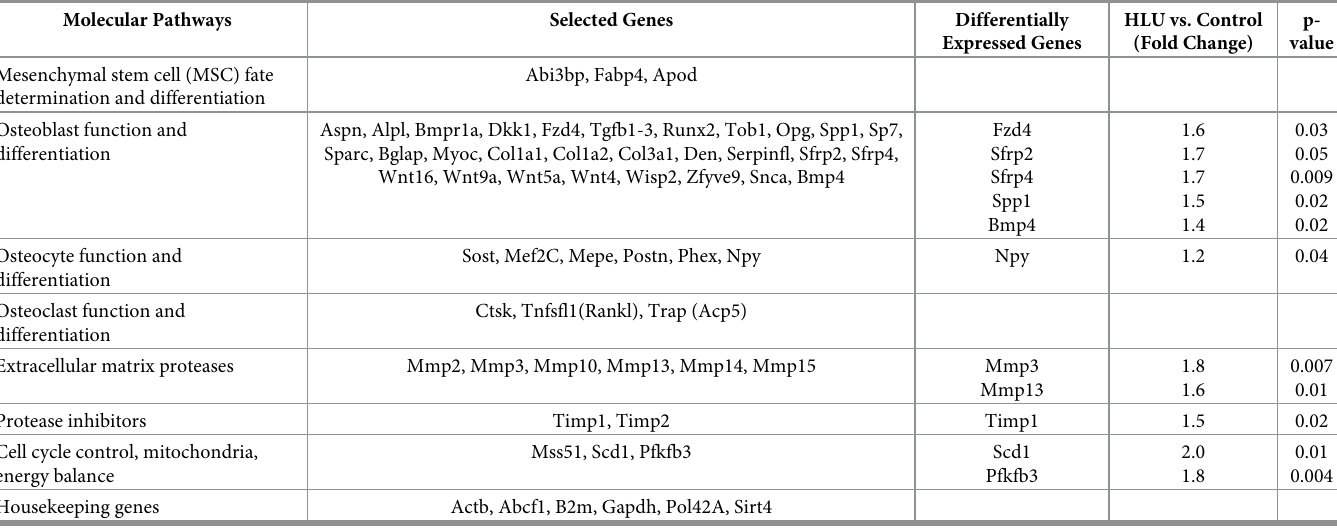
Table 1. Differentially expressed genes in the control and hindlimb unloaded (HLU) mouse cortical bone assessed by NanoString. Molecular